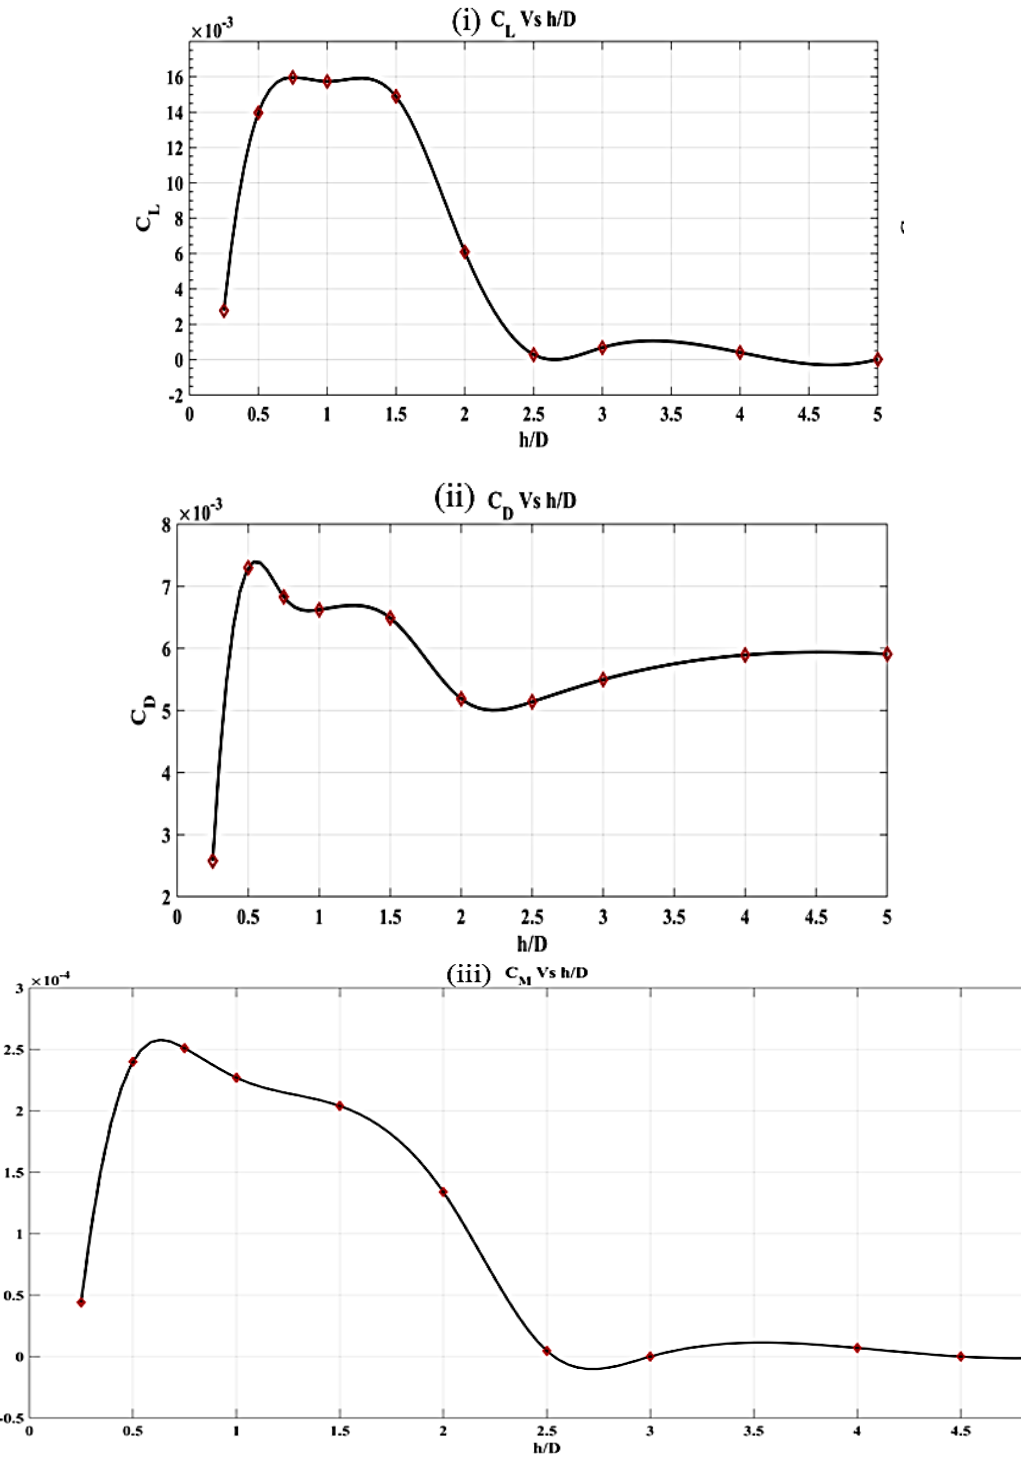
Figure 8: Variation of the computed drag, lift, and moment coefficient for different height to diameter ratios The variation in the moment coefficient is then plotted and can be seen in Figure 8iii. It can be observed that the moment coefficient decreased by 5.57 % as the h/D increased from 0.5 to 1, and height nearly doubled. Hence, a nose-up moment will take place due to the positive moment coefficients. A nose-up moment is only possible when a higher force is acting on the upper aft portion of the bullet or a higher force on the forward